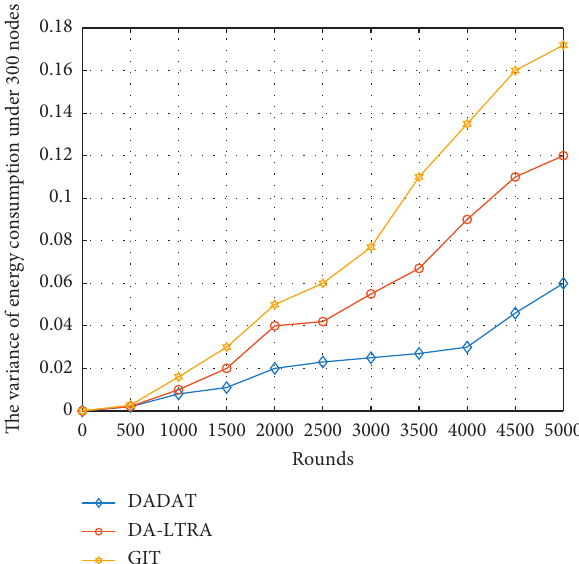
Figure 14: Overheads of delay under numbers of nodes.